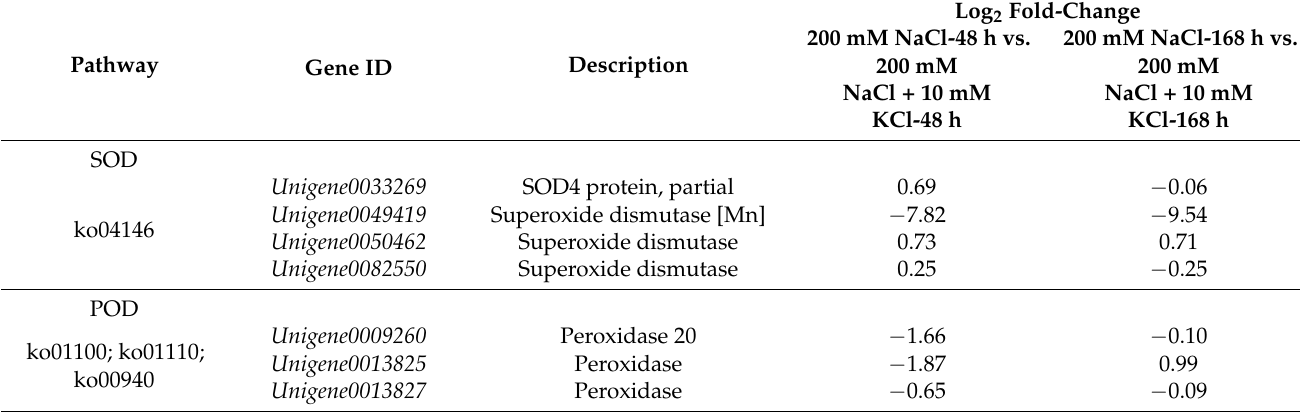
Table 2. Antioxidant DEGs annotated to the KEGG